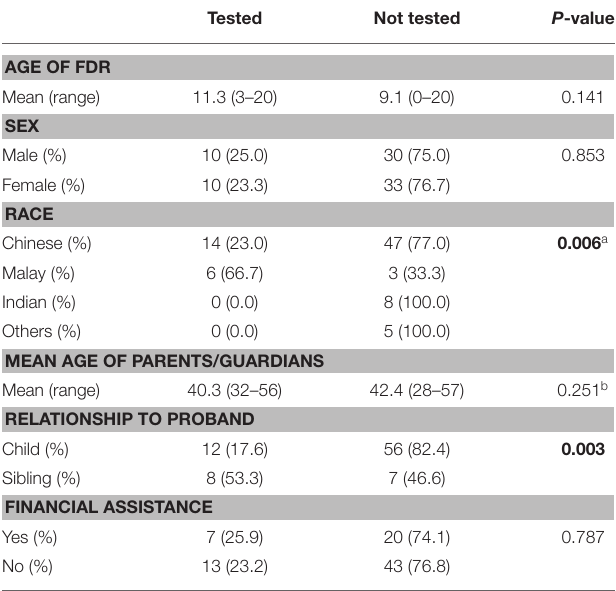
TABLE 4 | Factors associated with uptake of predictive testing in FDRs below 21 years old. Tested Not